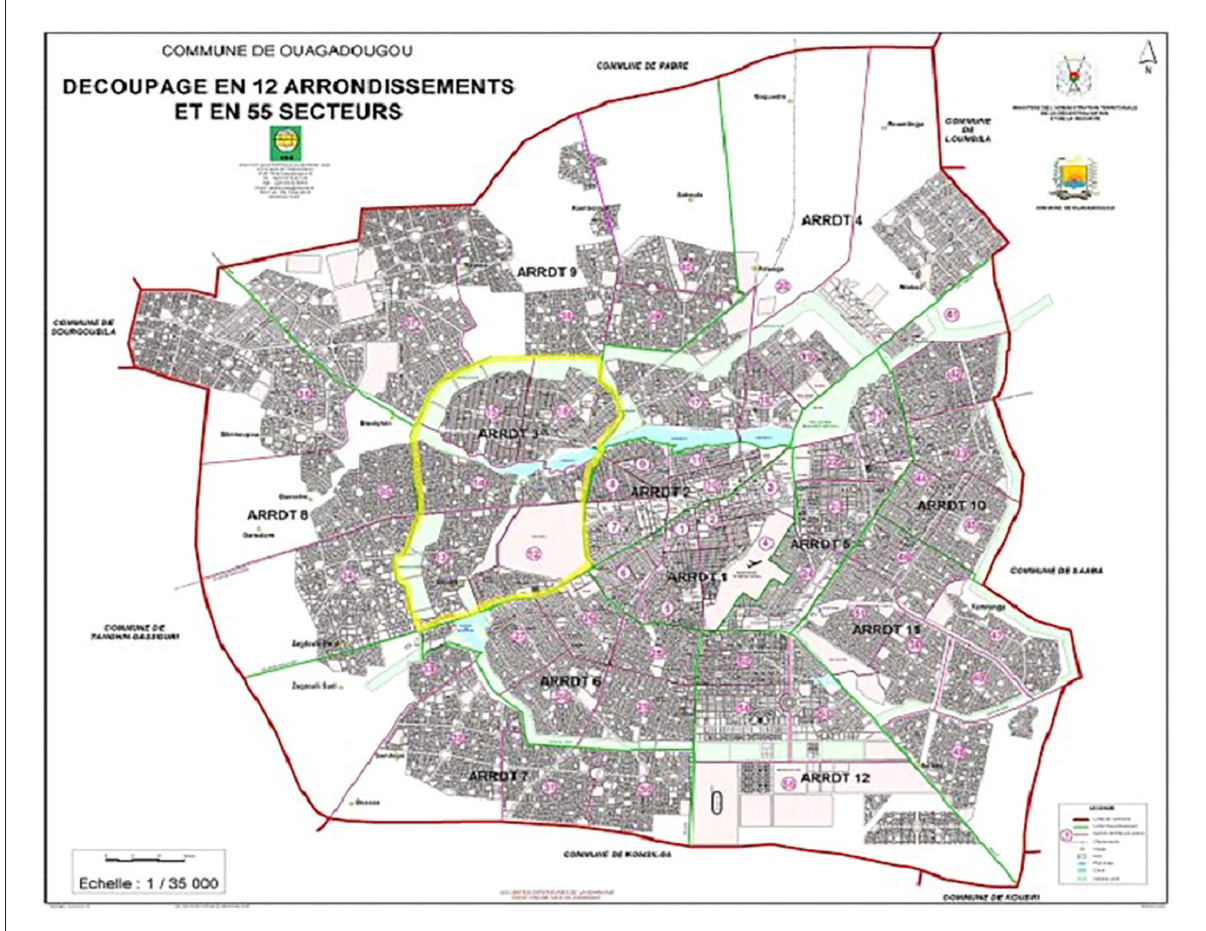
FIGURE1 Boroughs and sectors of Ouagadougou city. Source: https://www.sig-noghin.org/wp-content/uploads/2019/03/Carte-de-Ouaga-12-